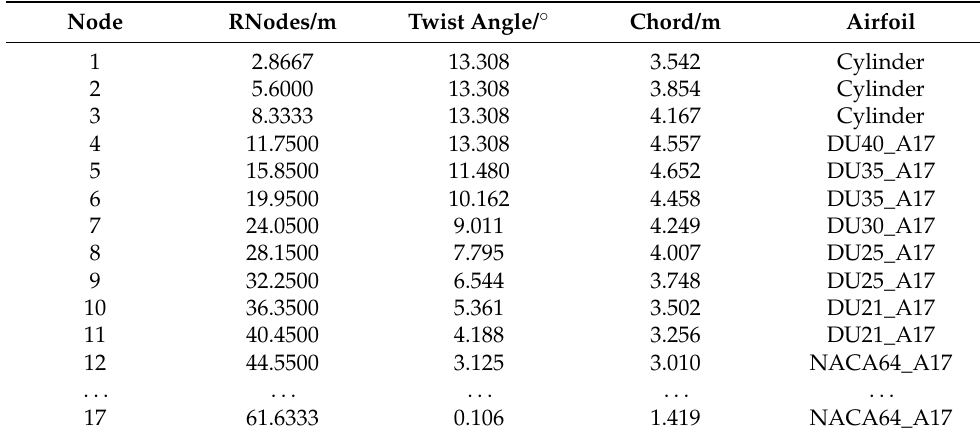
Table 1. Blade aerodynamic parameter distribution